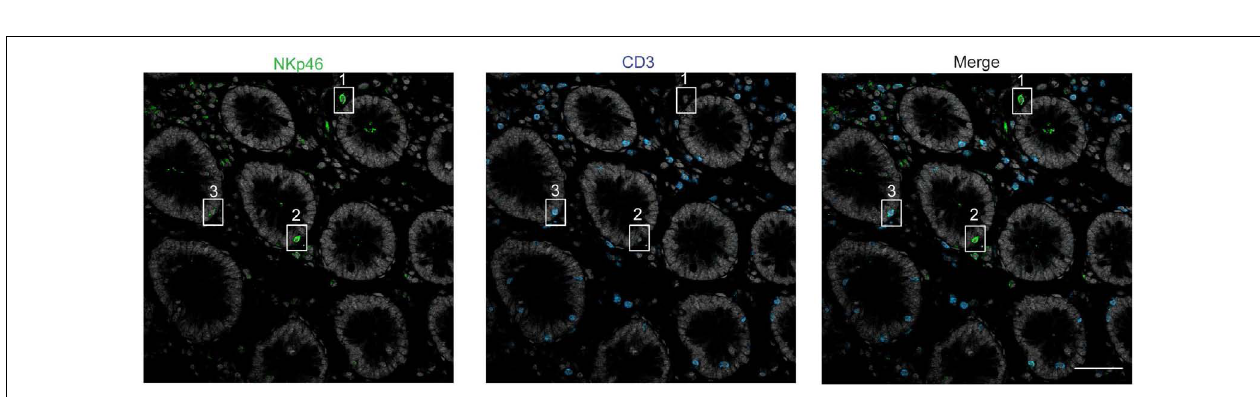
1 = NKp46 + CD3 − in gut lamina propria; inset 2 = NKp46 + CD3 − within epithelial cell layer; inset 3 = NKp46 + CD3 + within epithelial cell layer. One representative experiment performed on three distinct